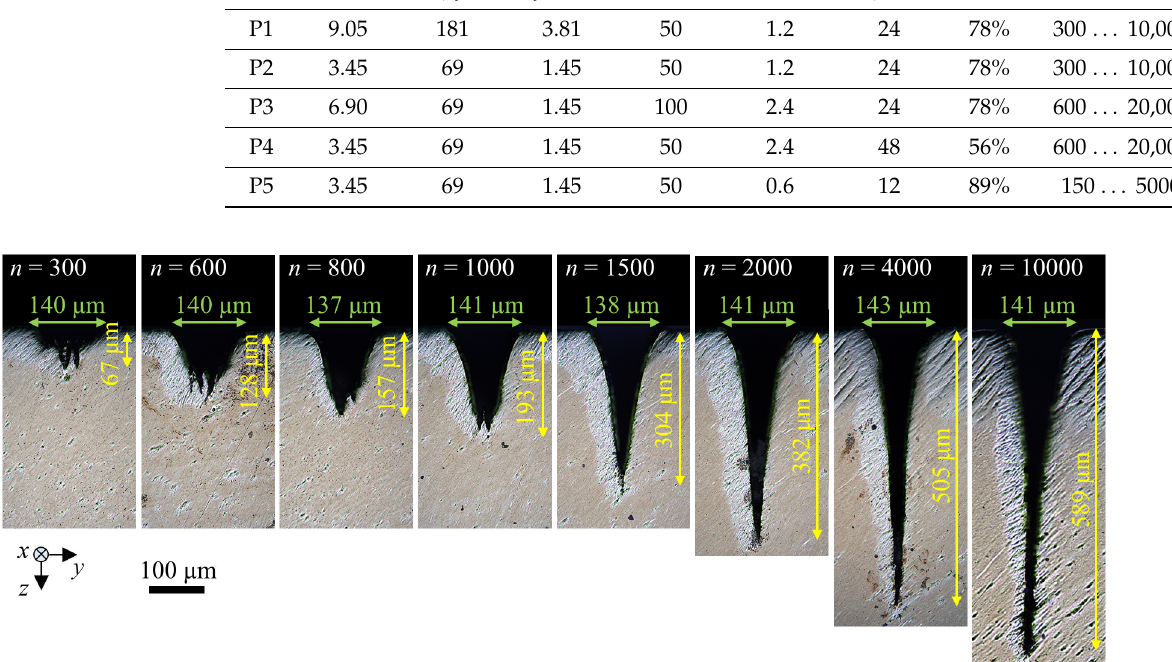
Figure 3. Cross sections of grooves micromachined in Ti6Al4V with the parameter set P1. The depth and width of each groove are indicated by a yellow double arrow and a green double arrow, respectively. Five grooves were machined with each of the parameter sets listed in Table 1. The measured values of the depth and width of the five grooves from each parameter set were